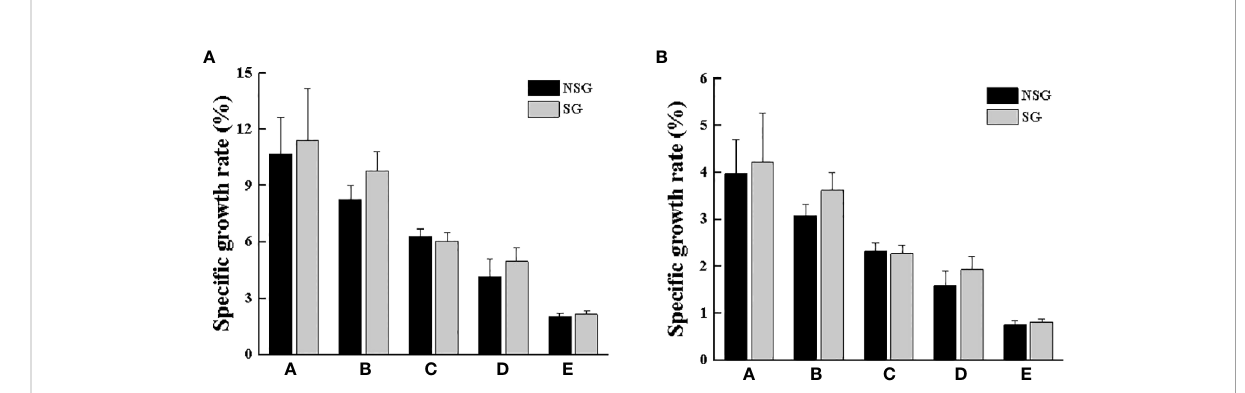
FIGURE 10 Speci fi c growth rates of body weight (A) and carapace width (B) of swimming crab with different body weight between NSG and SG. Unmarked letters indicate no signi fi cant differences ( P >